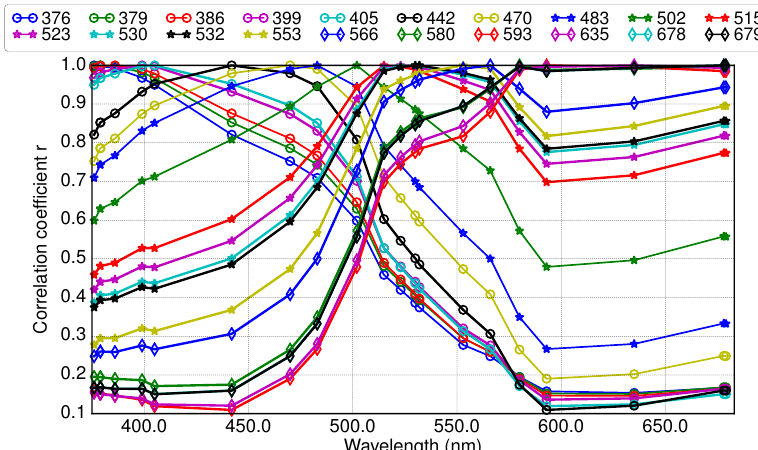
Figure 9. Correlation coefficients among the chosen bands for R rs for 10 nm.